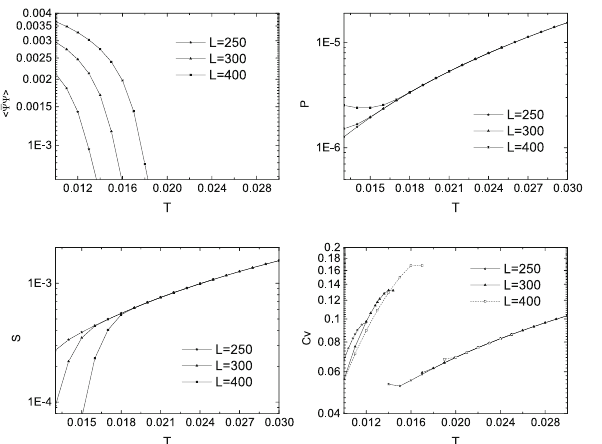
Fig. 10 The dependence of critical fermion mass and volume